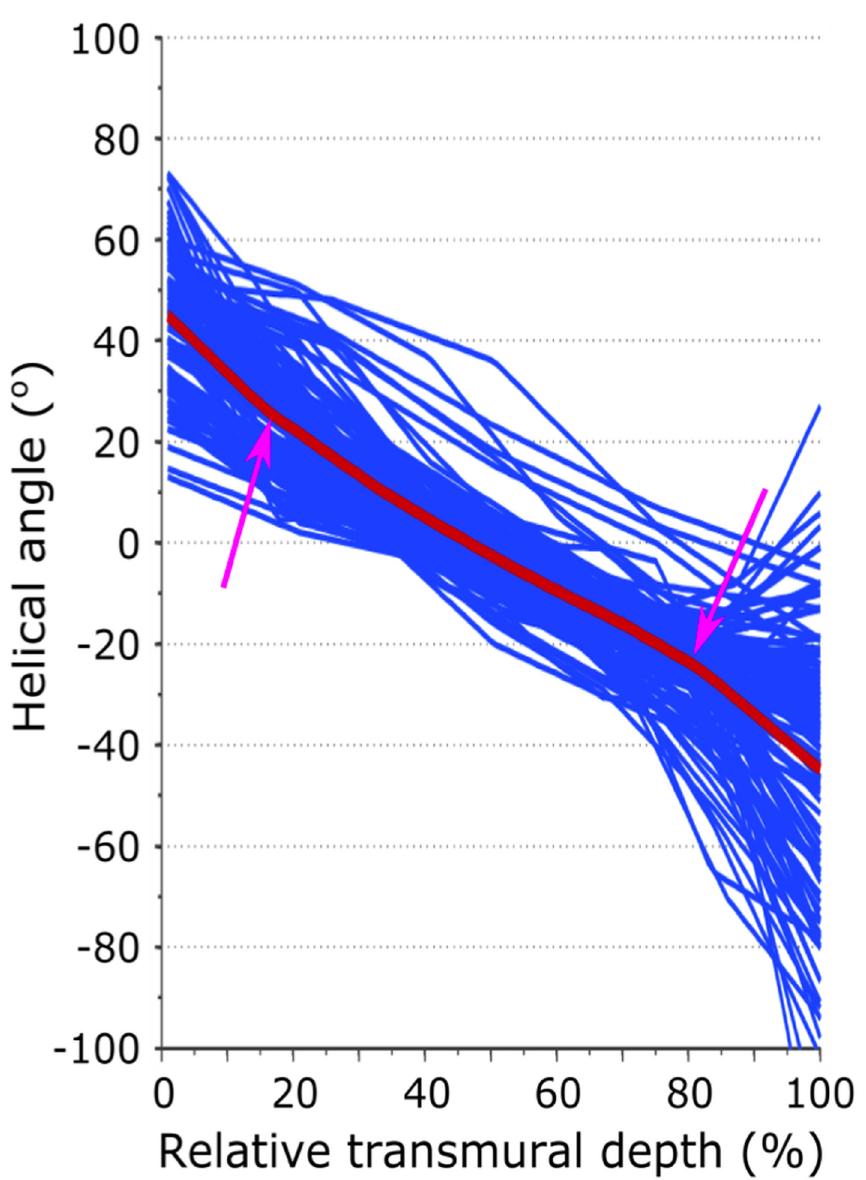
Fig 3. Example of regional HA line profiles. The x-axis shows the percentage distance from the endocardial surface. A relative reduction in the transmural helical angle gradient can be appreciated in the